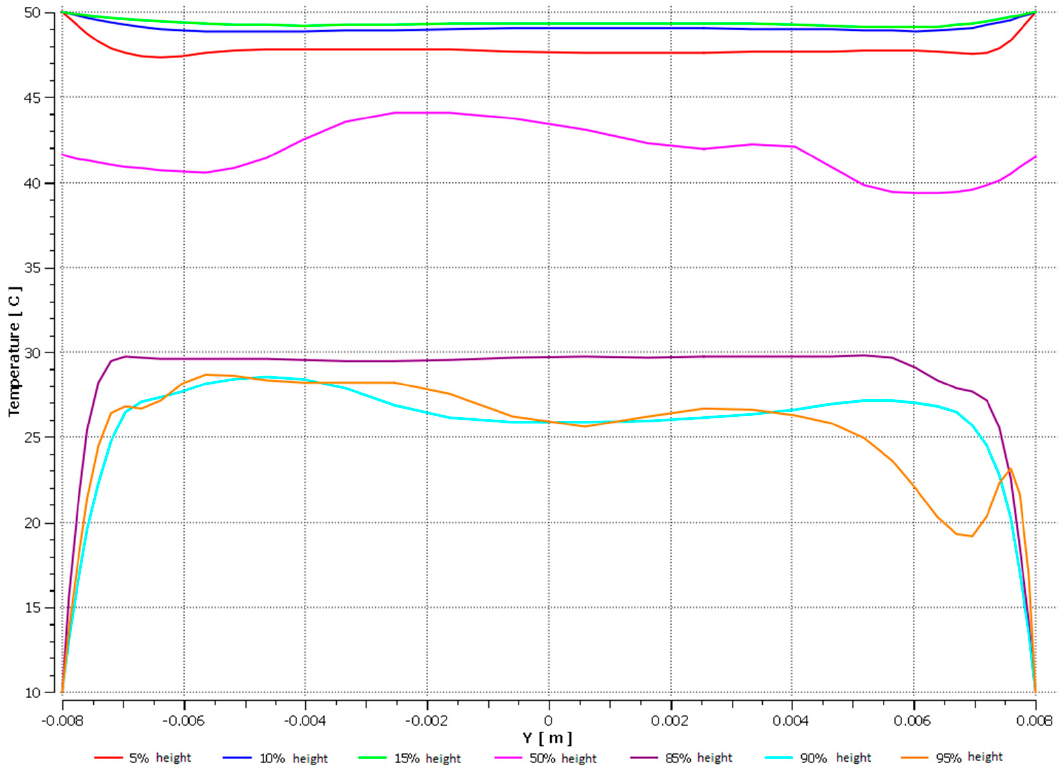
Figure 20. Temperature distribution along the cross-section.